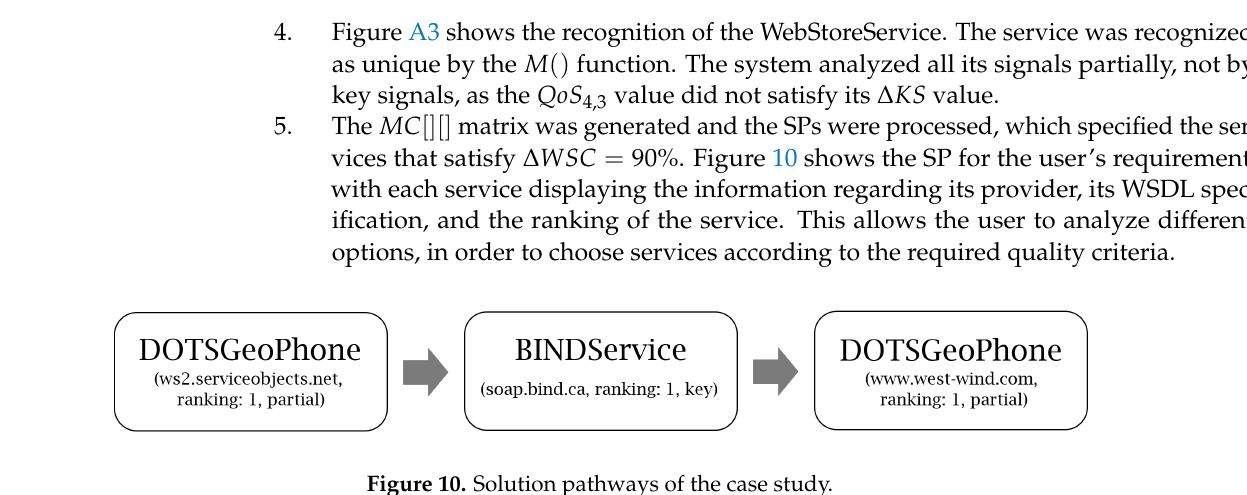
Figure 10. Solution pathways of the case study.